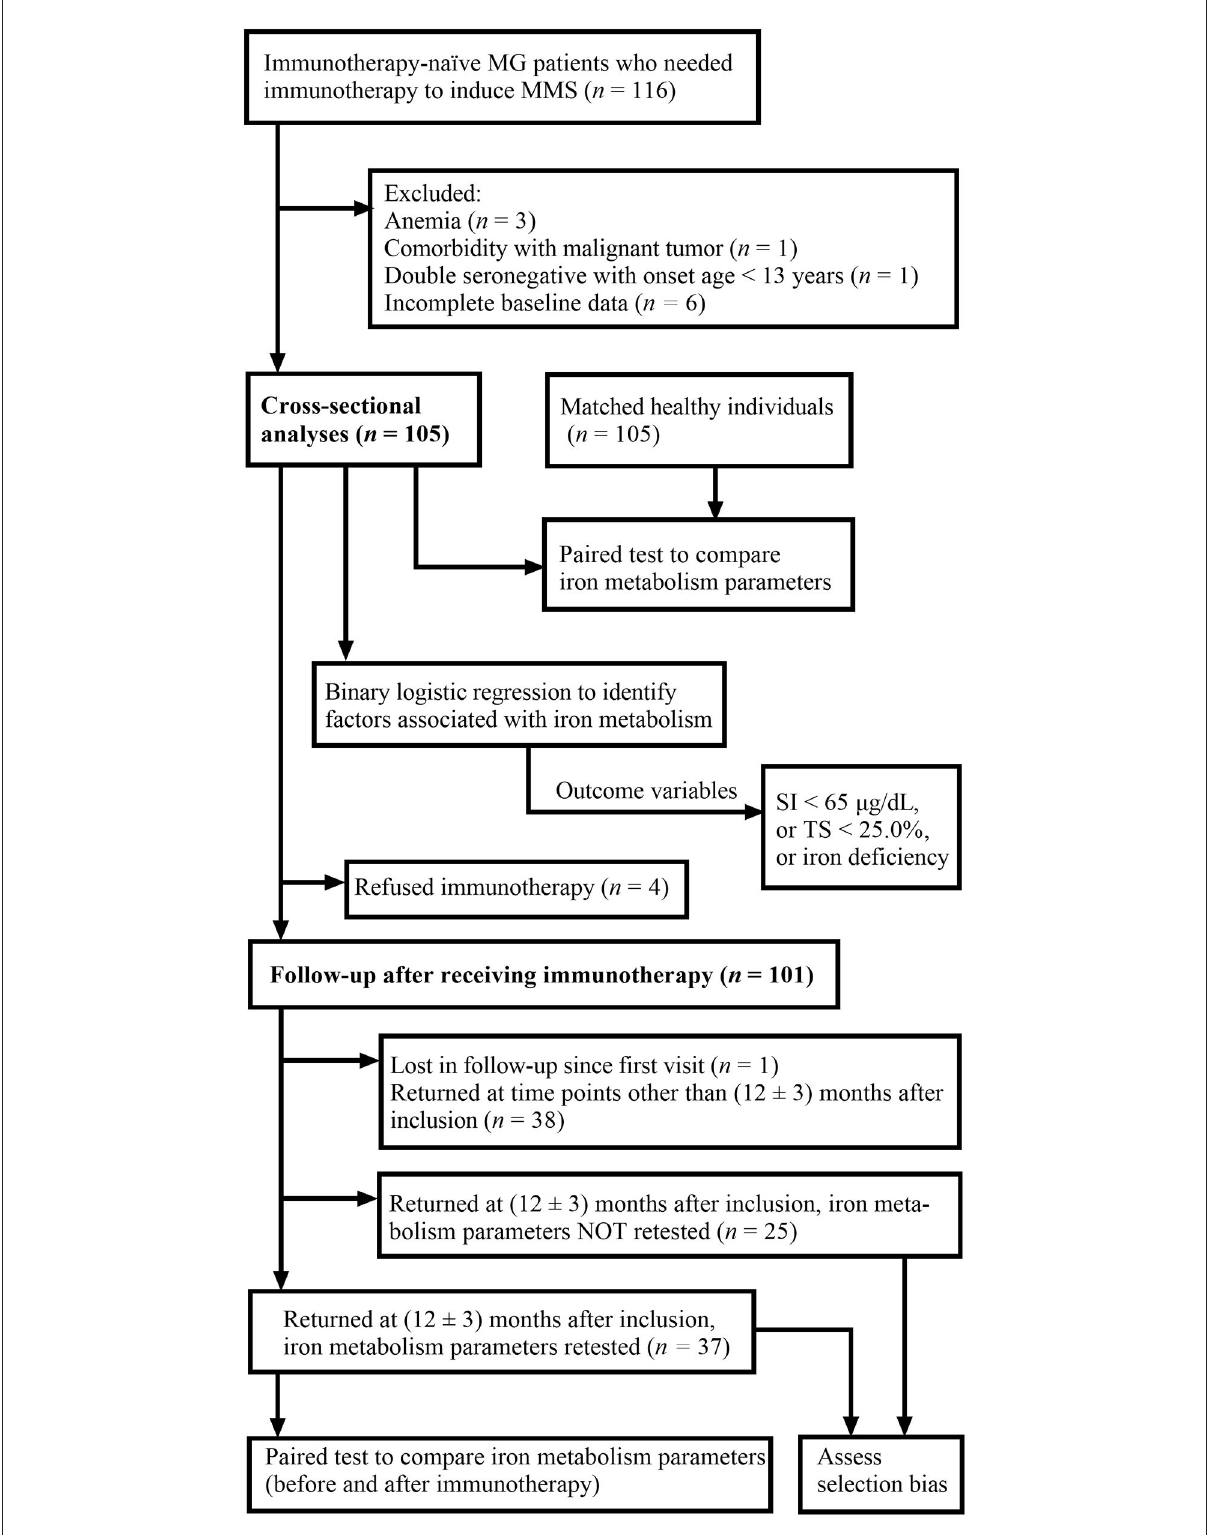
FIGURE1 Flowchart demonstrating the process of the study. MG, myasthenia gravis; MMS, minimal manifestation status; SI, serum iron; TS, transferrin